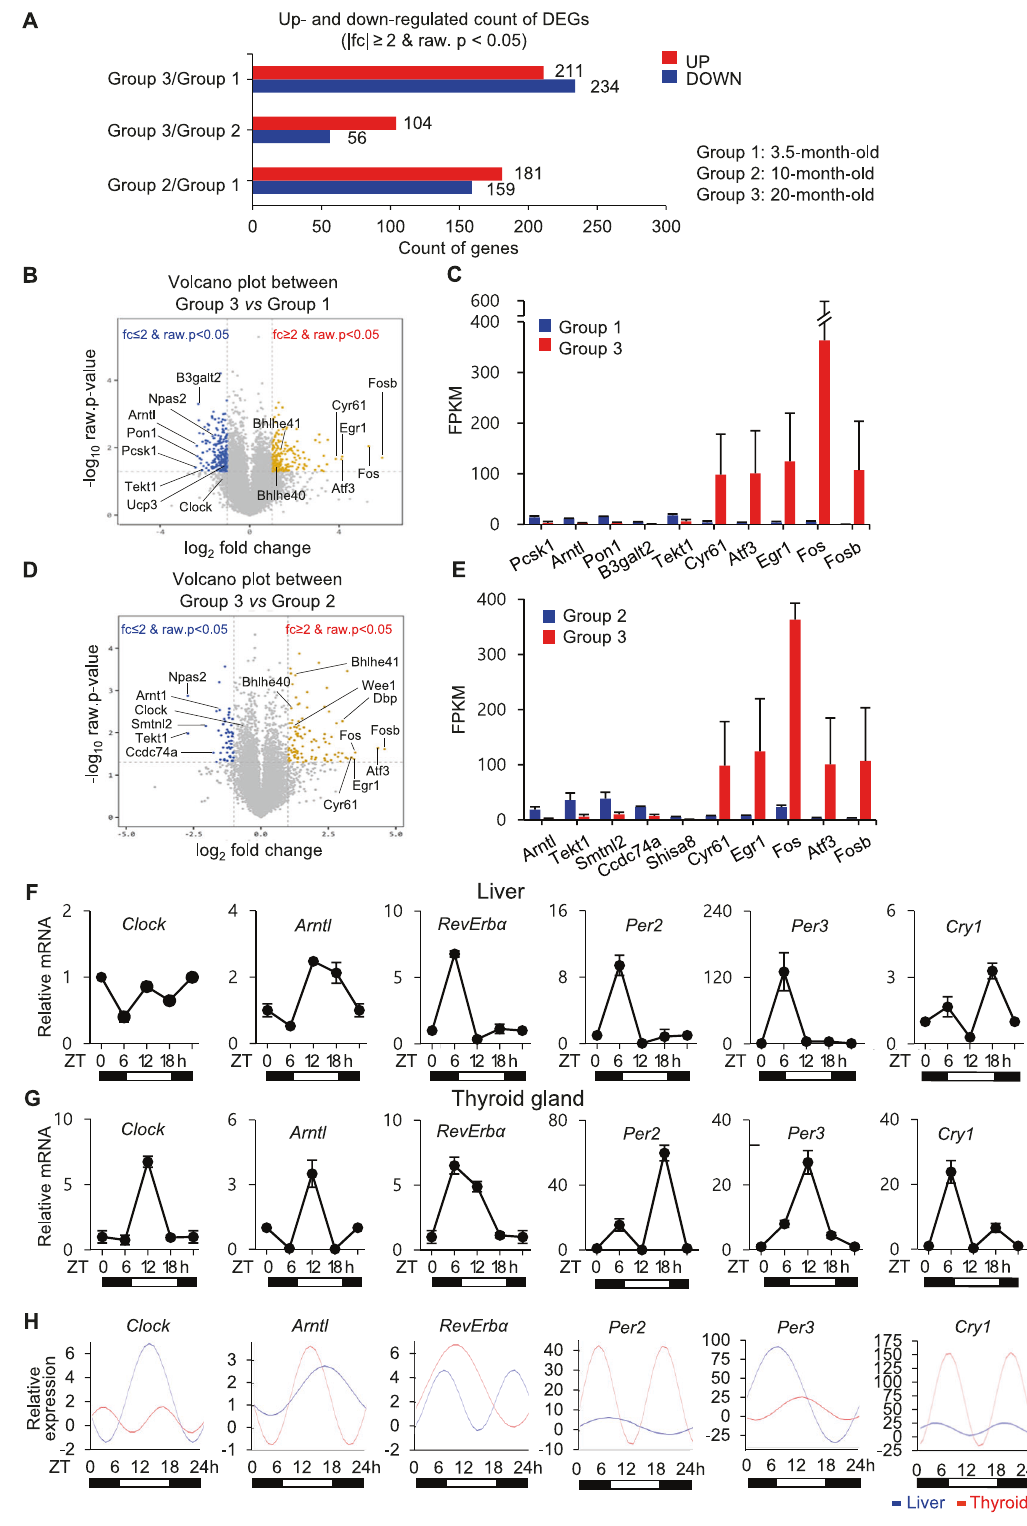
Cosinor-based rhythmometry analysis Cosinor analysis was used to assess the circadian rhythmicity of clock genes, such as the periodicity and the distribution of changes in expression over time (CosinorJ software version 1.0) [20]. Three cosinor parameters (MESOR, amplitude, acrophase) were included in the study [21, 22].